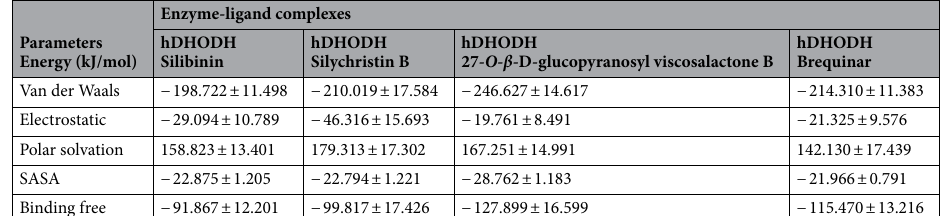
Parameters Energy (kJ/mol)